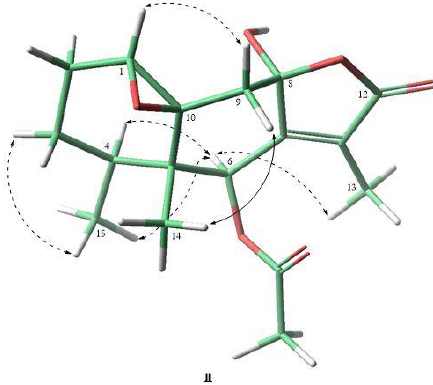
Figure 4. NOESY of compound 3 .